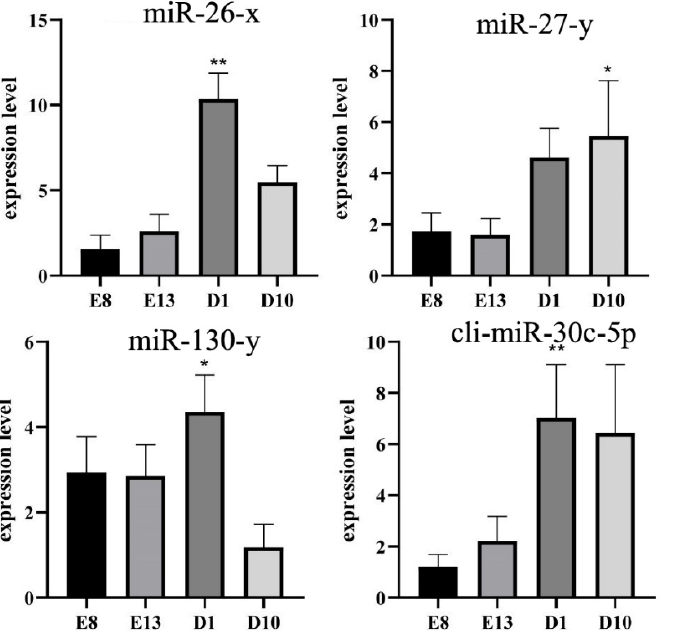
Figure 6. Validation of hub genes using RT-qPCR. ** indicates a very significant difference ( p < 0.01); * indicates a significant difference ( p < 0.05). * indicates a significant difference ( p <